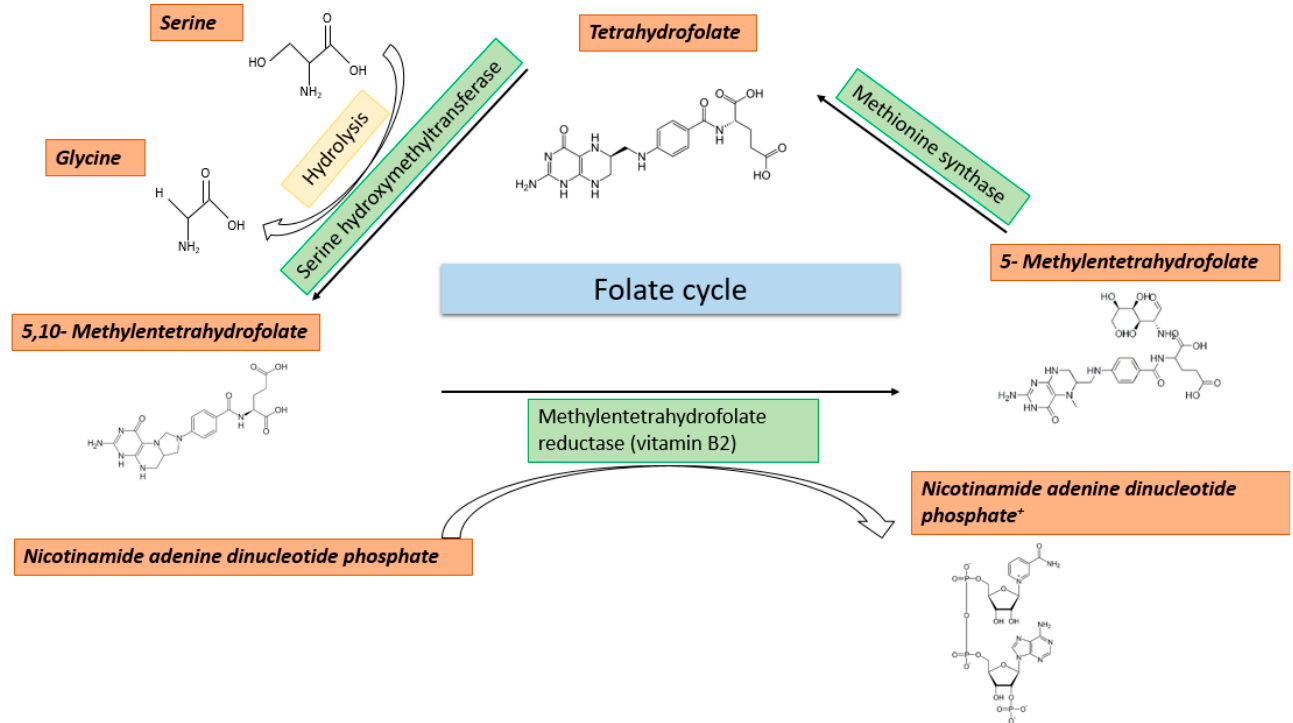
Figure 1. The folate